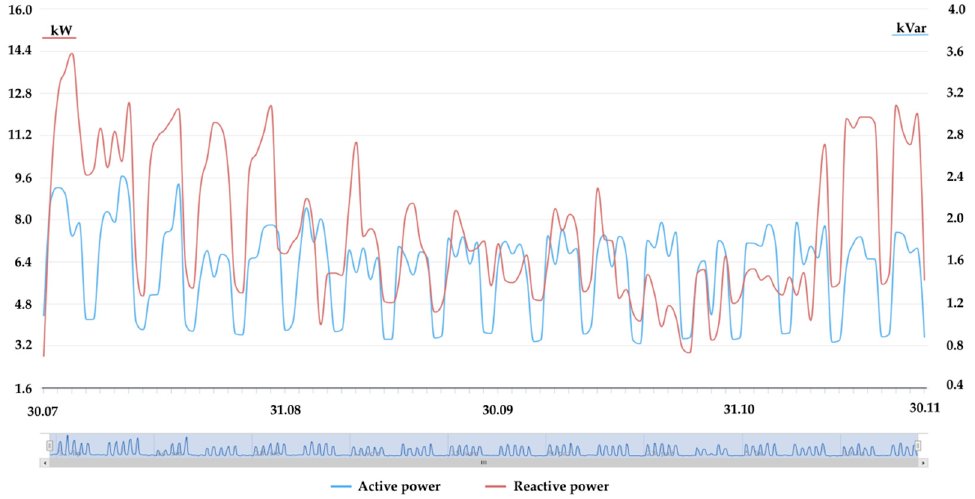
Figure 9. Screenshot of the supervisory application presenting active and reactive power consumption in the period of 1/August/2017–30/November/2017.